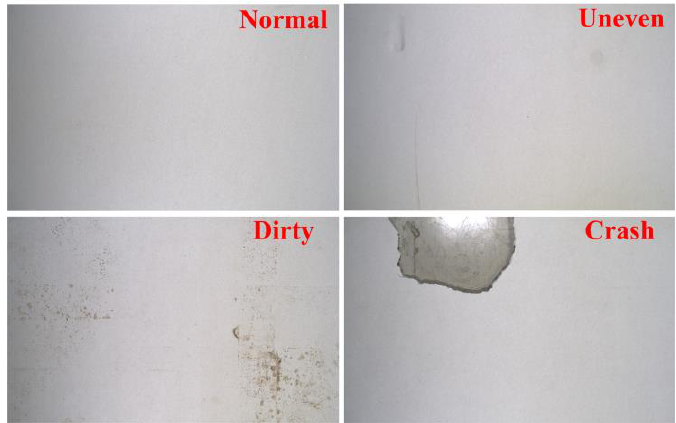
Figure 10. Four categories defined in the private CSB dataset. From top left to bottom right: normal, uneven, dirty, and crash.